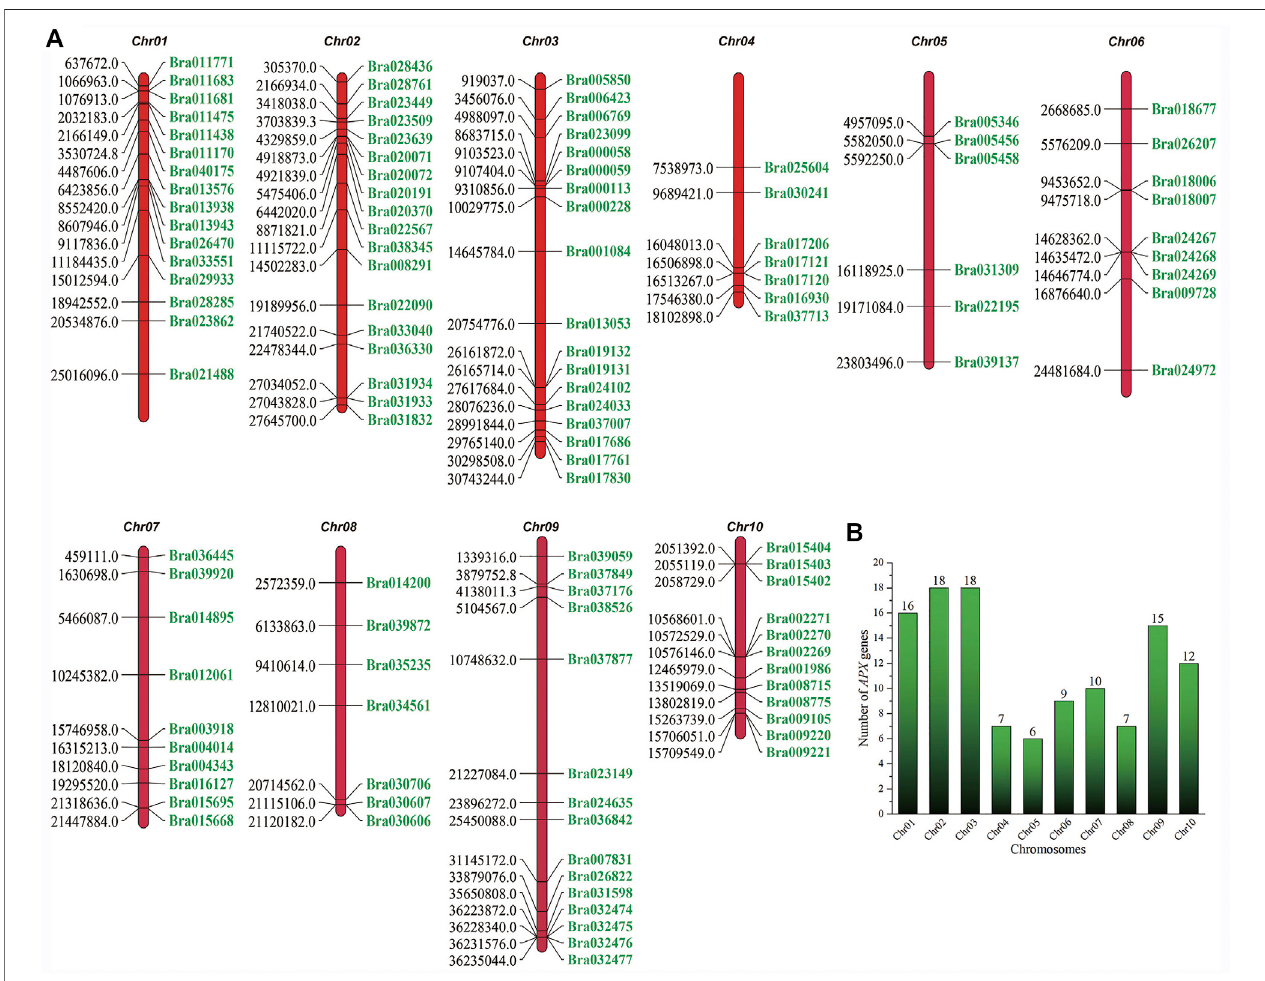
FIGURE 1 | Chromosome mapping of the APX genes in B. rapa . (A) Map of the distribution of B. rapa APX genes on 10 chromosomes. The numbers on the left indicate the location of the APX genes in B. rapa (Mb), and the numbers on the right correspond to the gene number. (B) Number of APX genes on each